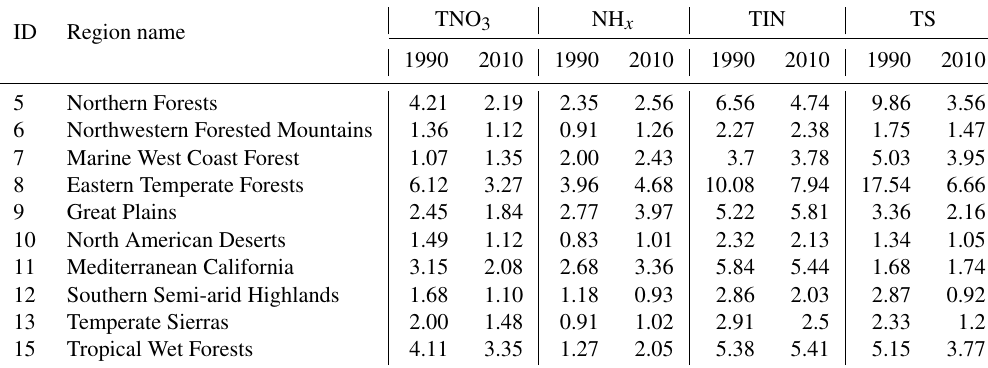
Figure 4. Spatial distribution of annual TDEP of total inorganic nitrogen (TIN, kgNha − 1 , a – c ) and sulfur (kgSha − 1 , d – f ) in 1990 (a, d) , 2010 (b, e) , and the simulated trends of the TIN ( c , kgNha − 1 yr − 1 ) and total sulfur ( f , kgSha − 1 yr − 1 ) TDEP changes over the 2 decades. Grey areas on the right plots show p value for the standard two-tailed Student t test greater than 0.05 (i.e., areas where trend estimates were not significant at the 95% confidence level). Table 5. TDEP (WDEP + DDEP; units of kgNha − 1 for nitrogen deposition including TNO 3 , NH x , and TIN and kgSha − 1 for TS) in 1990 and 2010 for the 10